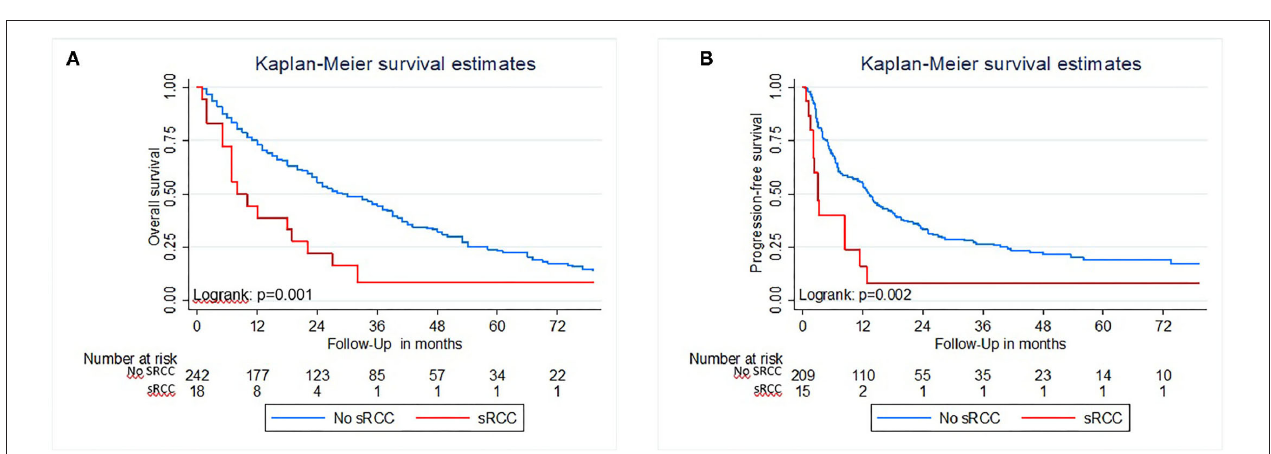
FIGURE 2 | Kaplan Meier estimates of Overall survival (A) and Progression-free survival (B) of patients with metastatic renal cell carcinoma treated with TKI with and without sarcomatoid features in histology.